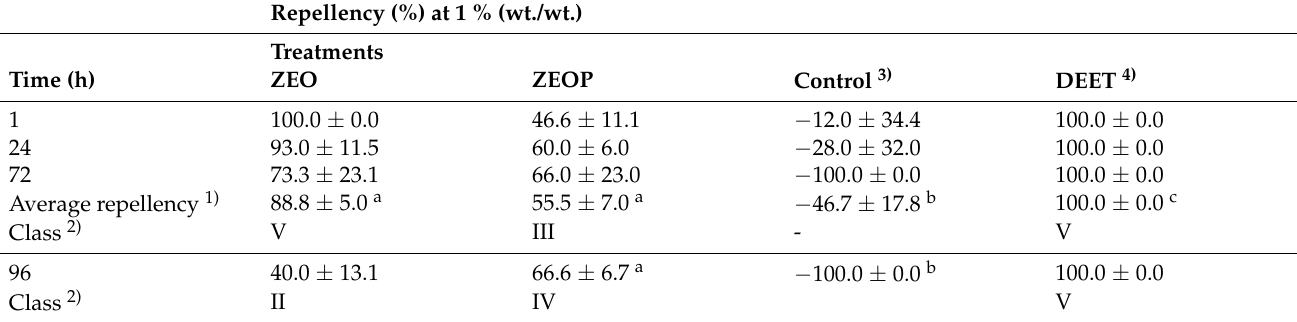
Table 4. Repellent activity of ZEO, and ZEOP against T. infestans nymphs fifth instars, the vector of Chagas disease (mean ± SD, n = 5) at 1.0%